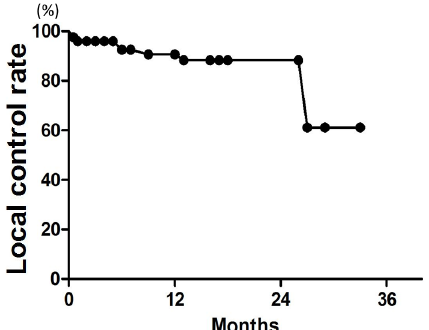
Figure 1. Local control (LC) curve for all 128 brain